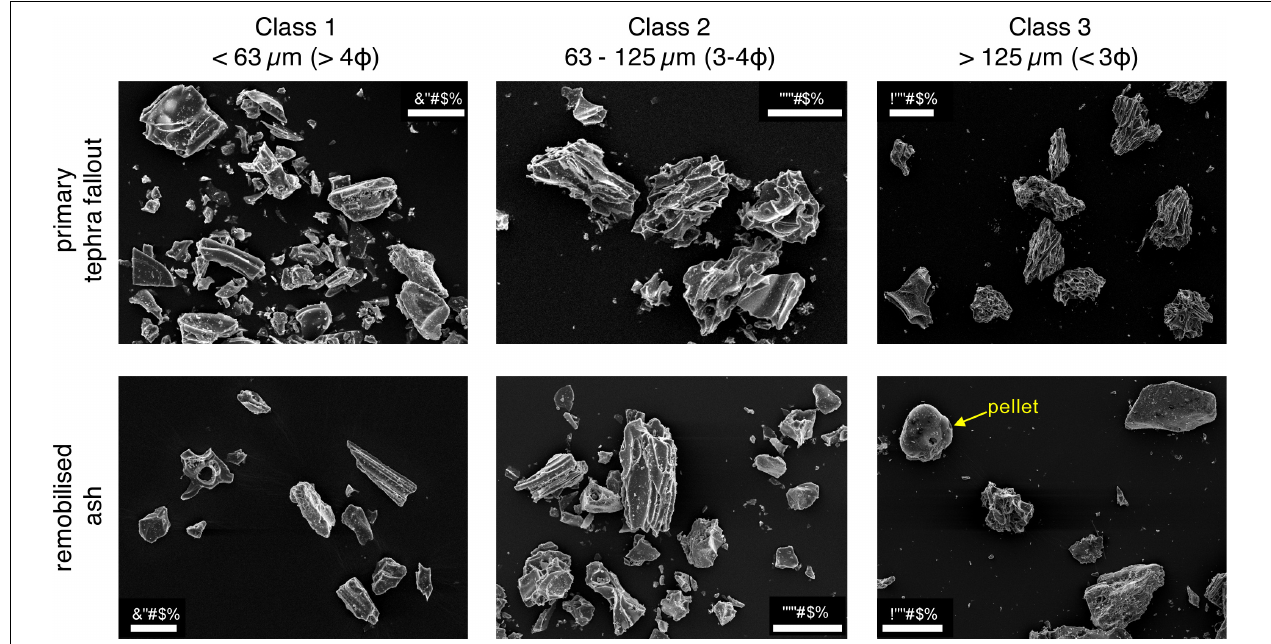
FIGURE 8 | Backscattered SEM images of primary tephra-fallout and remobilised ash particles classified by phi